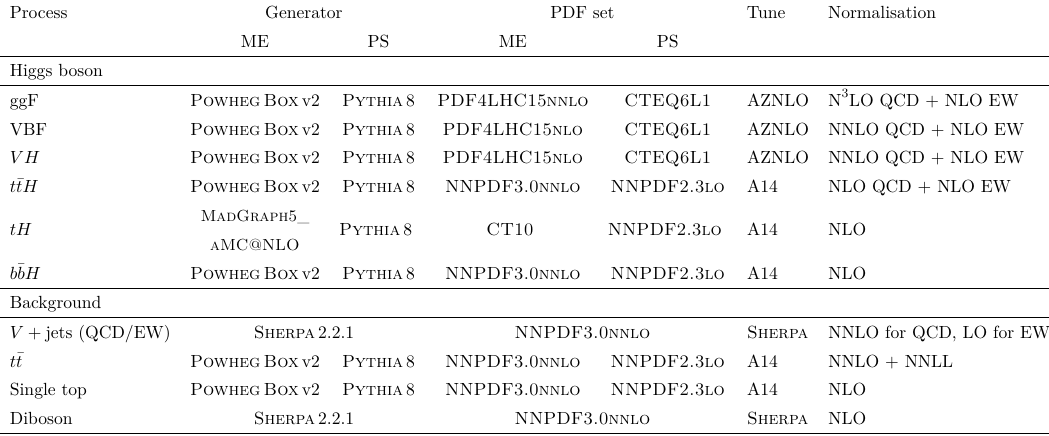
Table 1. Overview of the MC generators used for the main signal and background samples. The last column, labelled ‘Normalisation’, specifies the order of the cross-section calculation used for the normalisation of the simulated